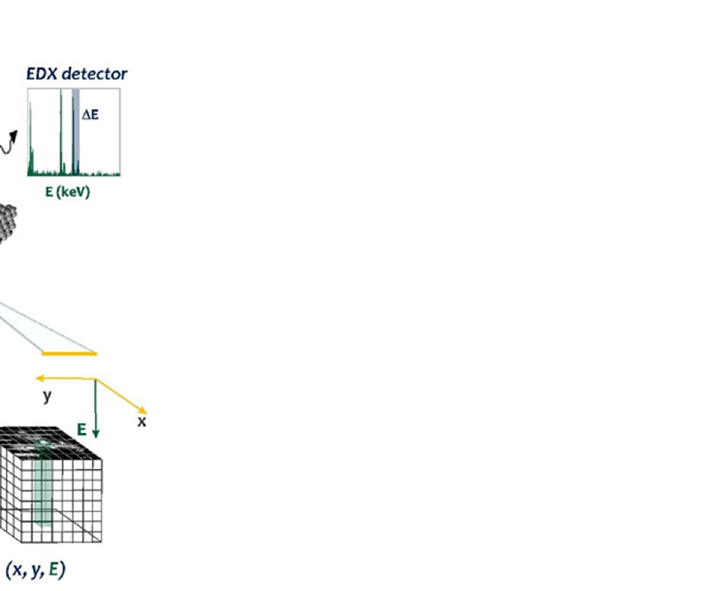
Figure 1. Schematic layout of the Spectrum Imaging (SI) method in STEM mode. The STEM probe is rastered over the specimen (x, y), and local information is retrieved by mapping the HAADF and EDX signals against to the position of the probe (x, y, E). The EDX spectrum shows the characteristic EDX peaks above the background signal. The obtained STEM-HAADF structural images can be complemented by elemental information extracted slice-by-slice, while sampling the EDS spectrum energy space I with an energy corresponding to the ∆ E range of the EDS characteristic